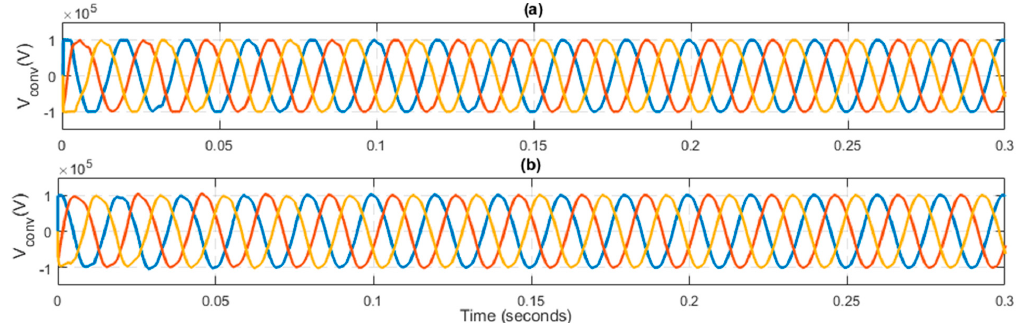
Figure 8. Upper arm capacitor voltage ( a ) Proposed controller; ( b ) PR controller.